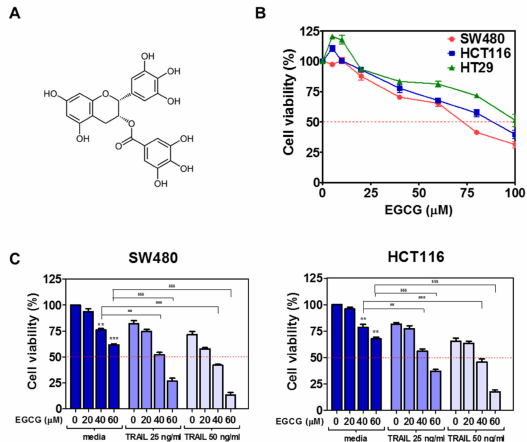
Figure 1. Synergistic cytotoxic e ff ect of epigallocatechin-3-gallate (EGCG) and tumor-necrosis-factor -related apoptosis-inducing ligand (TRAIL) cotreatment in colorectal cancer cells. ( A ) Chemical structure of EGCG. Molecular weight = 458.37. ( B ) SW480, HCT116 and HT29 cells were seeded into 96-well microplates and treated with various concentrations (5, 10, 20, 40, 60, 80, 100 µ M) of EGCG for 24 h. Cell viability was measured by 3-(4,5-dimethylthiazol-2-yl)-2,5-diphenyltetrazolium bromide (MTT) assay. ( C ) Synergistic e ff ect of EGCG on the cytotoxicity of TRAIL in SW480 and HCT116 cells. Two colon cancer cell lines were treated with the indicated concentrations of EGCG and / or TRAIL for 24 h. Then cell viability was analyzed using MTT assay. ** p < 0.01, *** p < 0.001 vs. untreated control, ## p < 0.01, ### p < 0.001 vs. TRAIL (25 or 50 ng / mL) at 40 µ M EGCGl, $$$ p < 0.001 vs. TRAIL (25 or